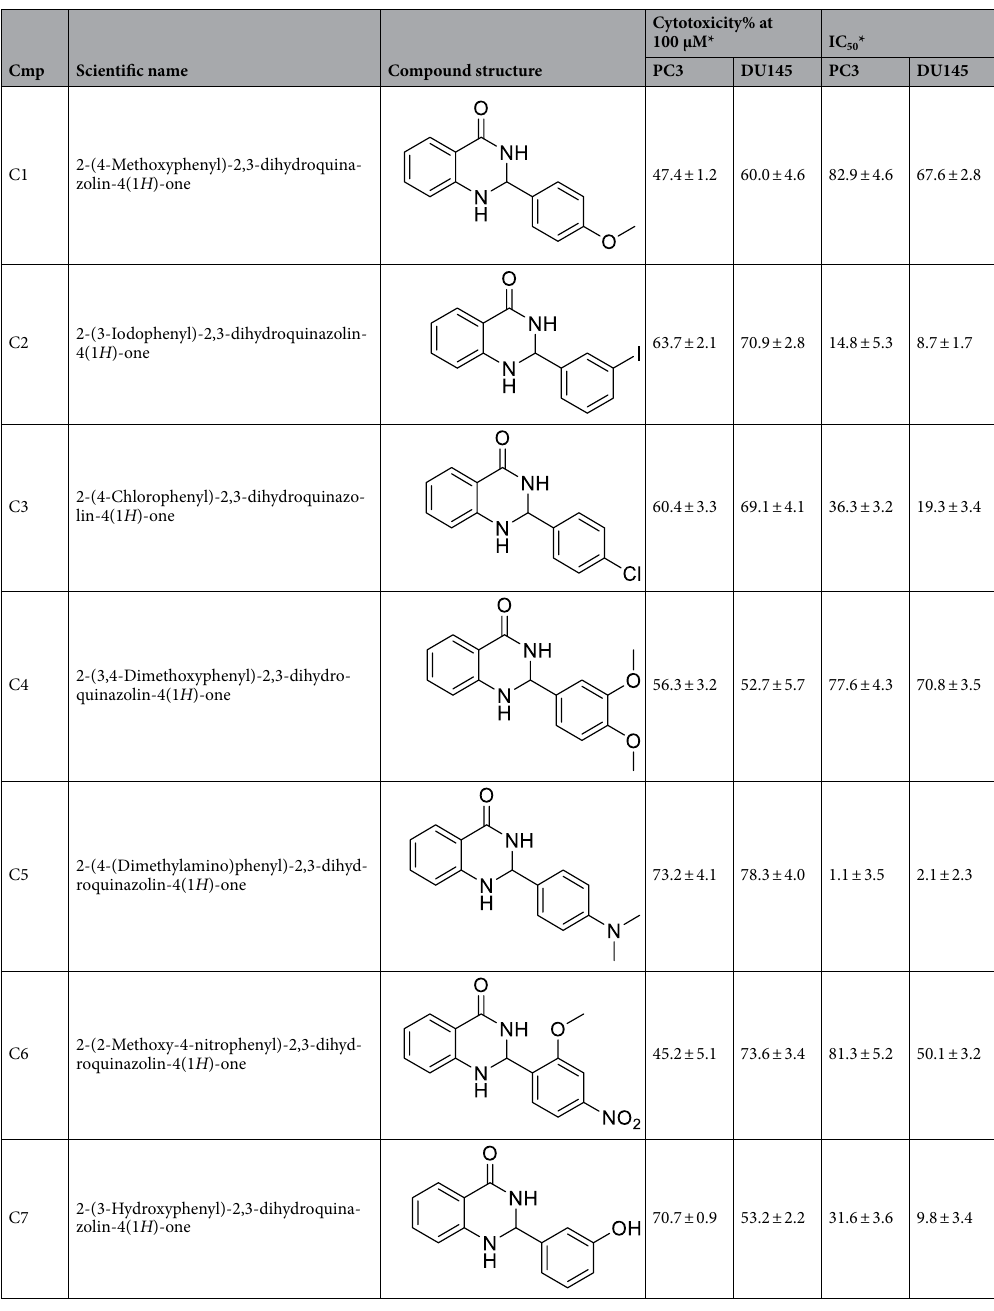
Table 1. Cytotoxic effect of the seven substituted 2,3-dihydroquinazolin-4(1H)-ones analogues (C1-C7) against PC3 and DU145 prostate cancer cell lines. *Data are presented as mean ± SD of three replicates of three independent